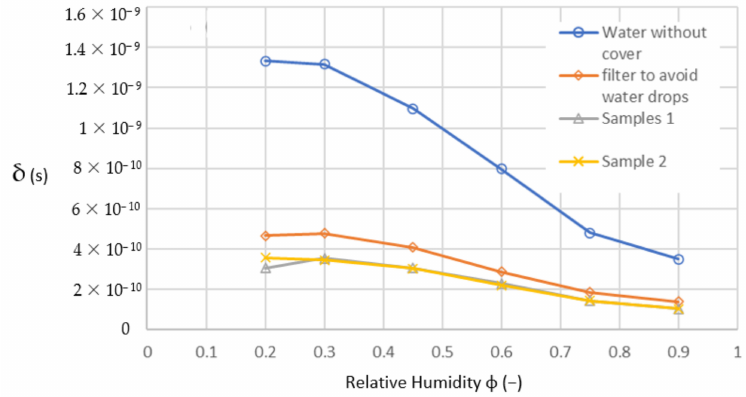
Figure 14. Diffusion coefficient calculated from measured data.